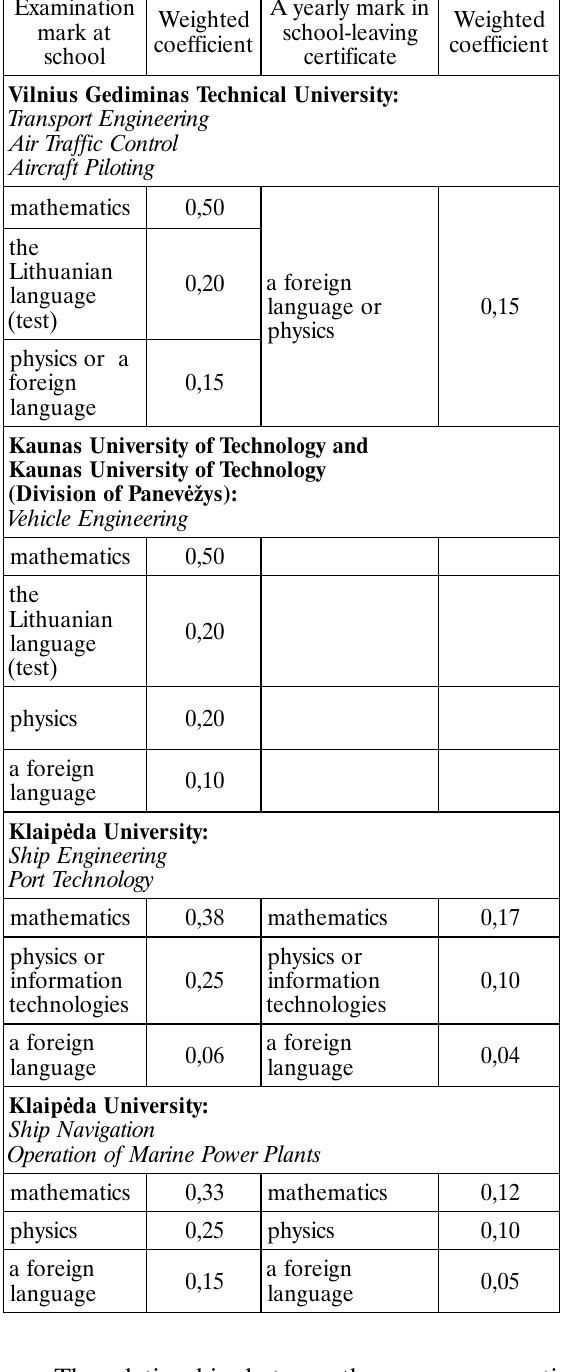
The relationships between the average competi- tive marks of all admitted applicants to full-time stud- ies in transport engineering courses and the highest possible mark are presented in Fig 9. The highest value of the relationship would be equal to unity.